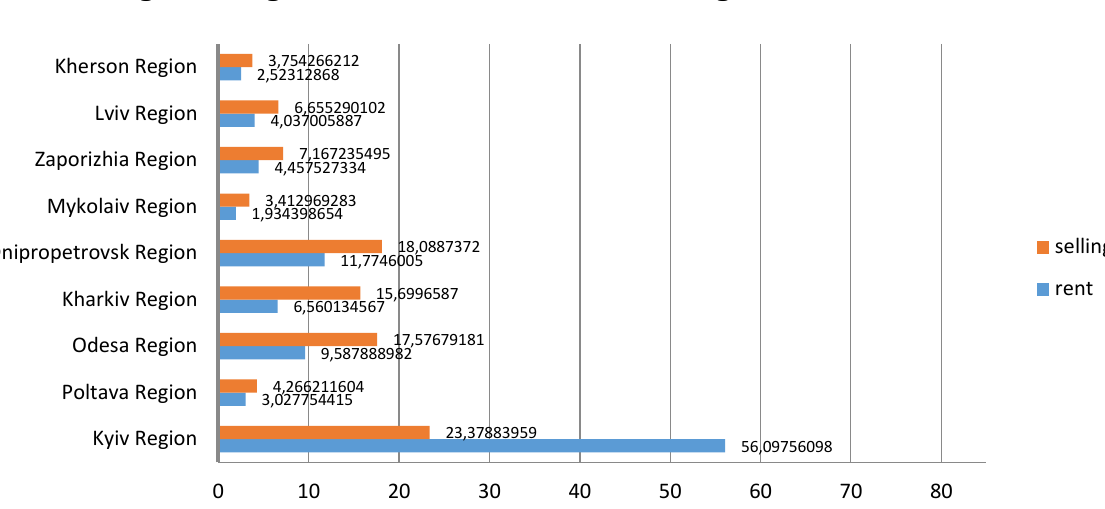
Figure 5: Regional structure of the offer of storage facilities of A and B class